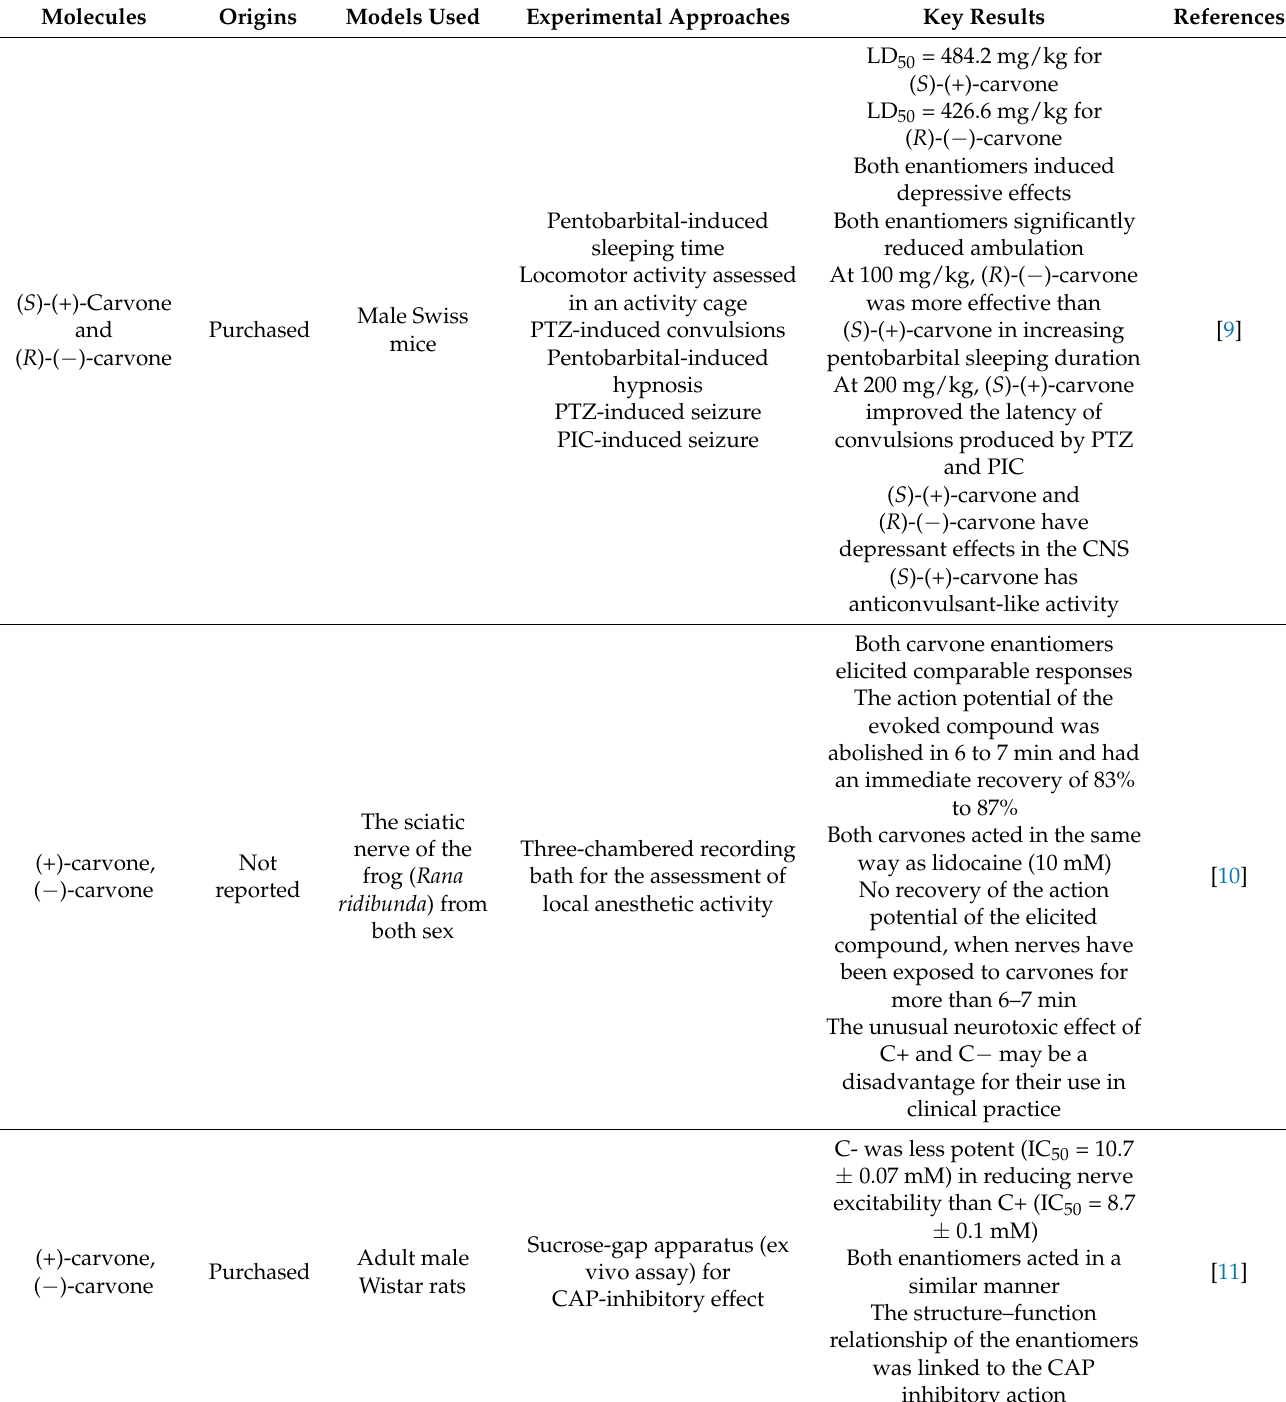
Table 1. Neurological activities of